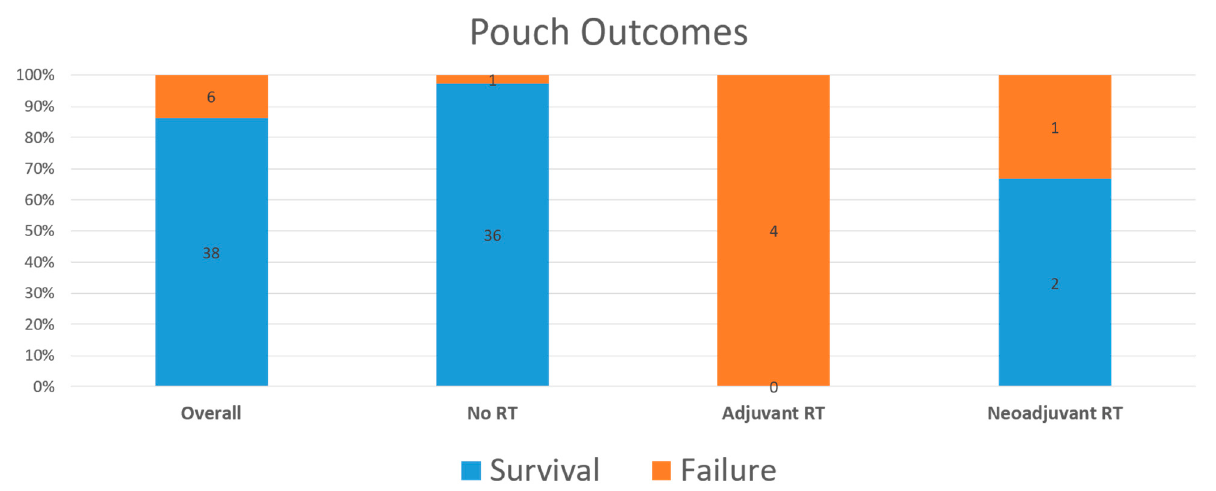
Figure 2. Functional outcomes of IPAA for rectal cancer in ulcerative colitis.